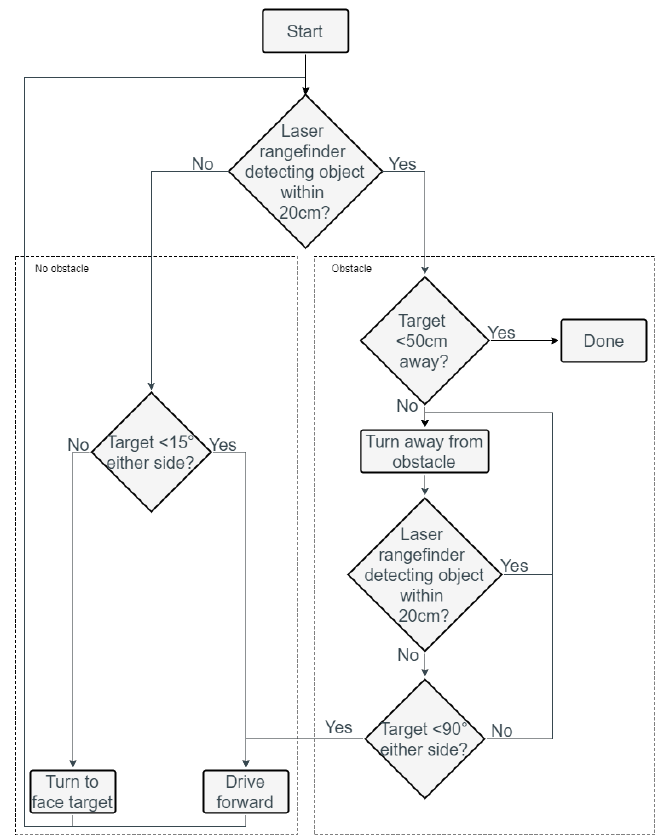
Figure 9. A simplified overview of the preliminary system control flow chart.